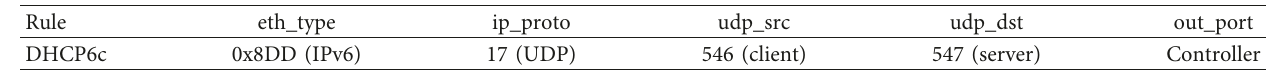
Figure 7: Matching packet header fields for rule DHCP4c of Table 1. Table 2: IPv6 address configuration rule.